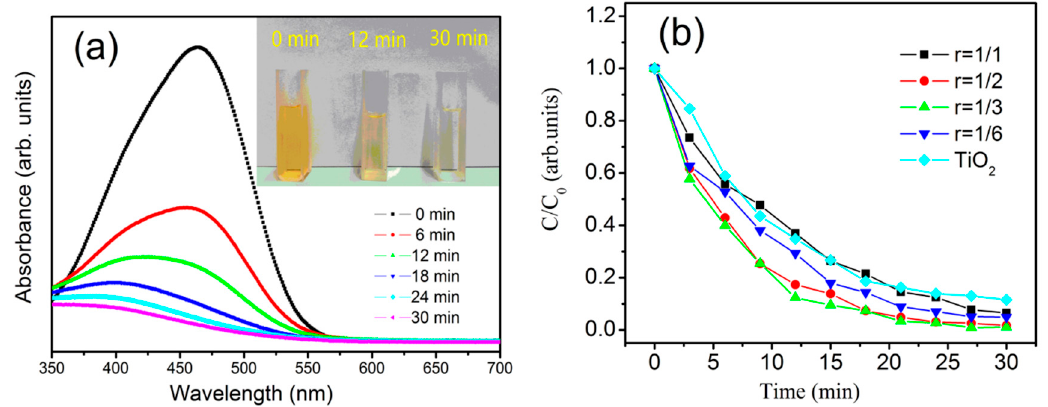
Figure 7. ( a ) Methyl orange absorbance of the films prepared at r = 1/3 at different times; ( b ) curve of methyl orange degradation by films prepared at di ff erent levels of r . For comparison, the degradation methyl orange degradation by films prepared at different levels of r . For comparison, the degradation curves of the TiO 2 films are curves of the TiO 2 films are presented.